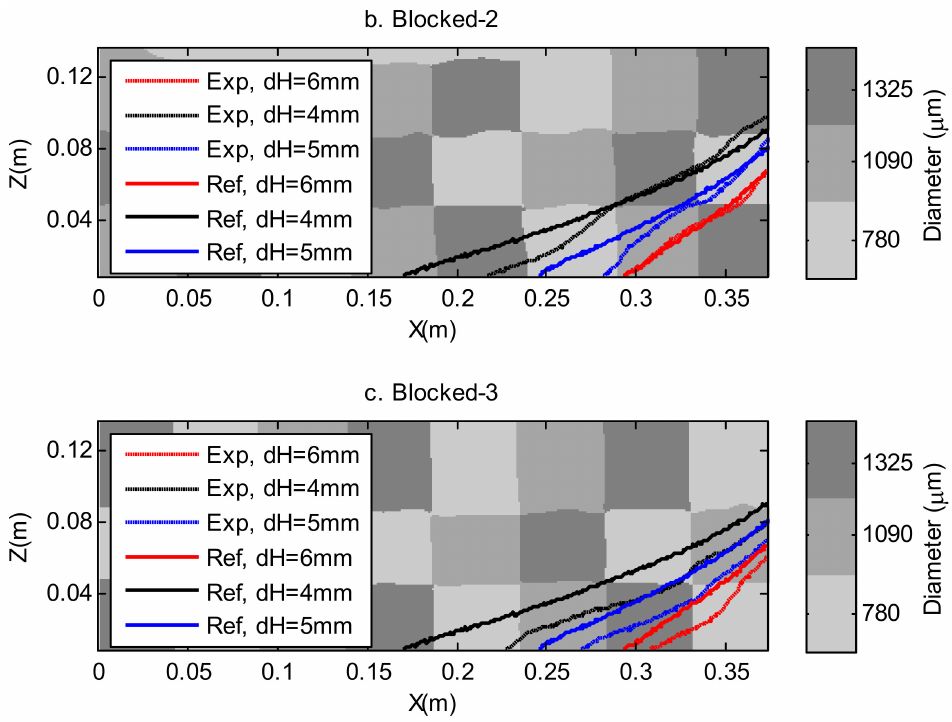
Figure 5. Experimental steady-state 50% salt concentration isolines for the blocked cases compared to the homogeneous reference case, at head differences, dH = 6 mm, 4 mm, and 5 mm. (( a ) blocked group 1, ( b ) Blocked group 2, ( c ) Blocked group 3).